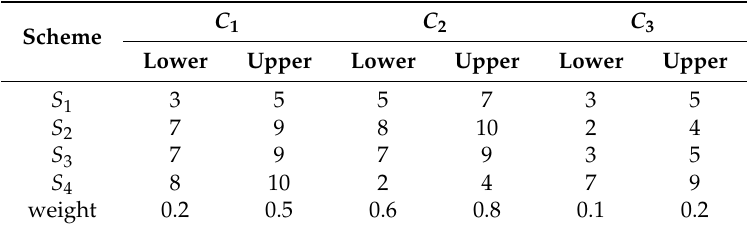
Table 2. Interval decision-making matrix and range of index weights [12].